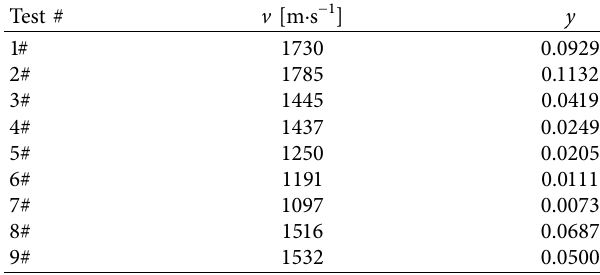
Table 1: The direct ballistic test data from